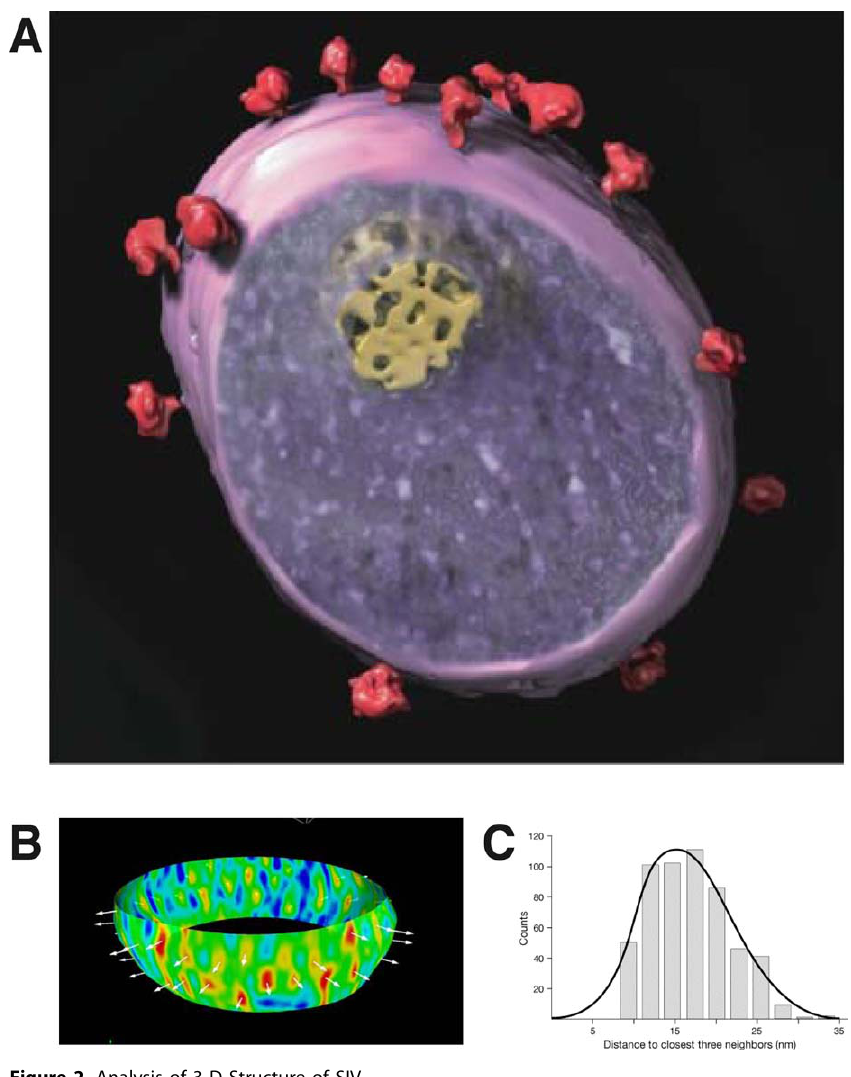
Figure 2. Analysis of 3-D Structure of SIV (A) Segmented representation of the surface and interior of a single virus from the data shown in Figure 1. For the sake of clarity, only selected regions of the interior and exterior are highlighted: elements shown include the viral envelope (magenta), viral spikes (red), core (yellow), and interior (translucent purple). (B) Surface plot showing automated detection of spikes on the surface of the viral membrane. (C) Nearest neighbor analysis to measure the distribution of distances between neighboring